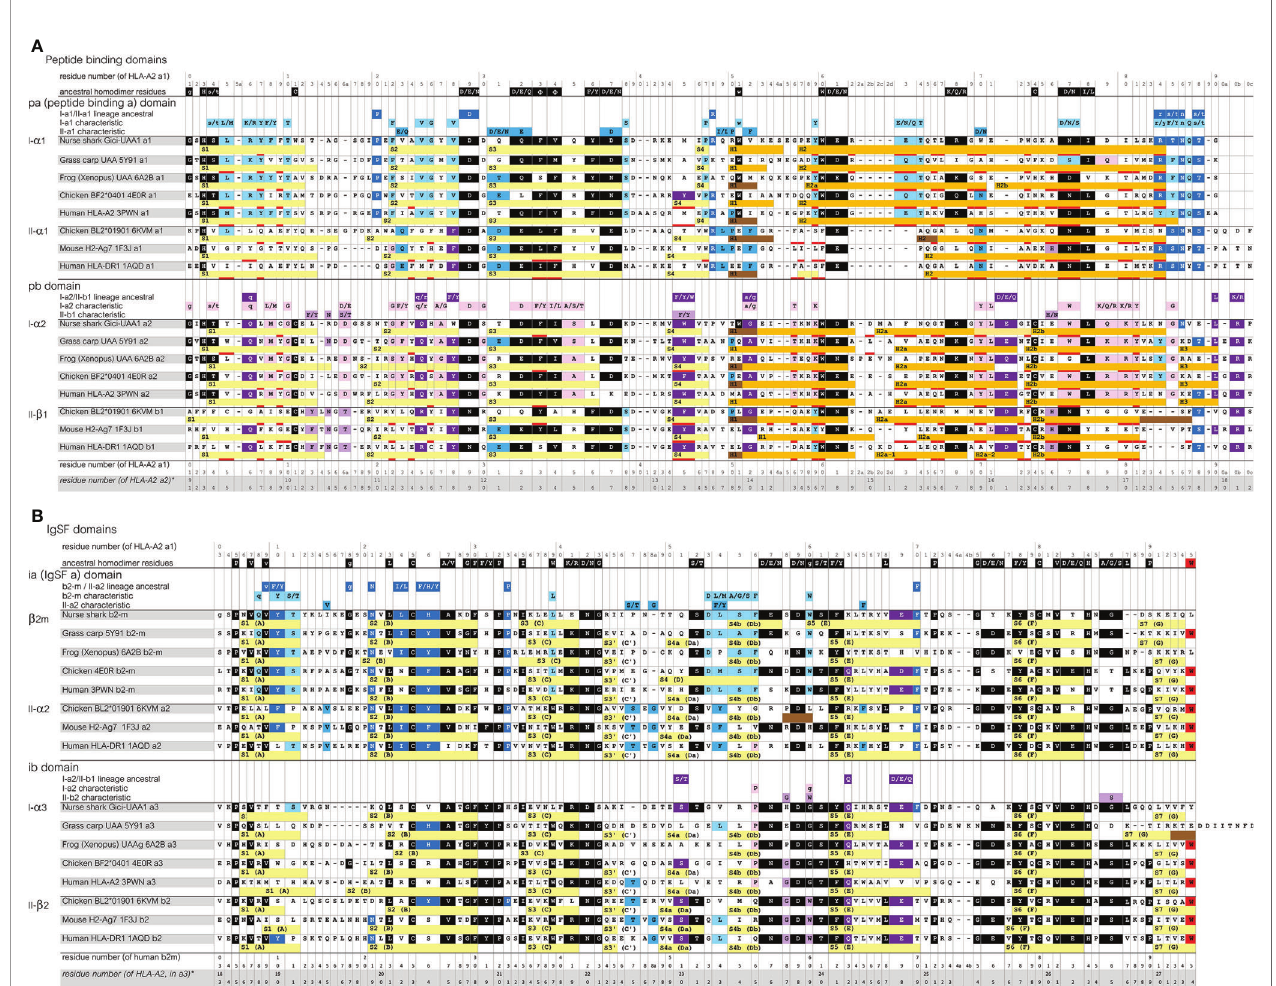
FIGURE 3 | Sequence alignment of representative MHC-I and MHC-II molecules for which the structure is known. (A) , pa and pb domains; (B) , ia and ib domains. Yellow, light orange, orange, and brown bars represent b -strands, p -helices, a -helices, and 3 10 -helices, respectively. Residues that are within 4.0 Å distance of the peptide ligand are red underlined. The b -strands are numbered S1, S2, and so on, but for the IgSF domains also the alternative A-to-G names are shown. Uninterrupted stretches of helical structures ( a -helices and/or 3 10 -helices) in the pab domain that are separated by kinks were named H1 and H2 for the pa domain, and H1, H2a (or H2a-1 and H2a-2), H2b and H3, for the pb domain (49, 50). In the shark UAA I- a 2 domain the “ kink ” between the H2a and H2b helices is in the shape of a p -helix. Residue coloring refers to conservation of (sets of) residues indicated above the alignments: black, inherited from the MHC homodimer ancestor; dark blue, ancestral to the I- a 1+ b 2 -m/II a lineage; purple, ancestral to the I- a 2+I- a 3/II b lineage; light blue, characteristic for the I- a 1+ b 2 -m lineage; pink, characteristic for the I- a 2+I- a 3 lineage. Small font of color-shaded letters above the alignment indicates uncertainty about the evolution pattern. PDB accessions for structures of the depicted sequences are: Nurse shark UAA*01, 6LUP (note: recombinant 6LUP b 2 -m possesses residue iaS3 and not the natural iaG3); Grass carp UAA, 5Y91; Frog (Xenopus) UAA, 6A2B; Chicken BF2*0401, 4E0R; Human HLA-A2, 3PWN; Chicken BL2*01901, 6KVM; Mouse H2-Ag7, 1F3J; Human HLA-DR1,